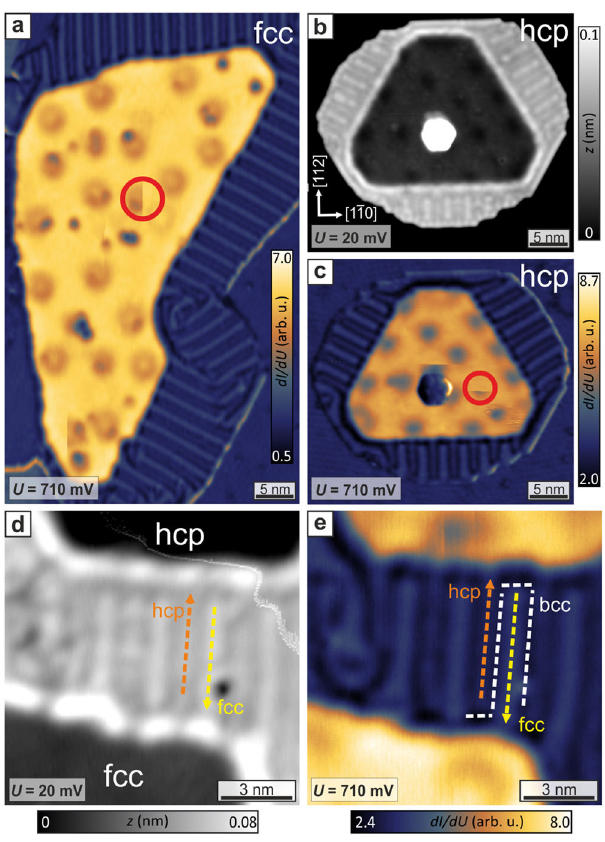
Fig. 4 Differences between fcc- an hcp-stacked Pd/Fe islands. a A differential conductance (d I /d U ) map of an fcc-stacked Pd/Fe island in an applied external fi eld. The contrast is dominated by the non-collinear magnetoresistance effect. b Constant-current image with apparent sample height z of a triangular hcp-stacked Pd/Fe island, surrounded by Co/Fe. c d I /d U map of the same island, scanned at a different bias voltage U . Red circles indicate skyrmions being written or deleted by the scanning procedure. d Close-up constant-current image of a Co/Fe area located between a hcp-stacked and fcc-stacked Pd/Fe island; the reconstruction pattern changes close to the island rim. e d I /d U map of the same area, the different hollow site sections, and the bcc(110)-like bridge sites can be clearly distinguished. All images: tunneling current I = 3 nA, B = 2